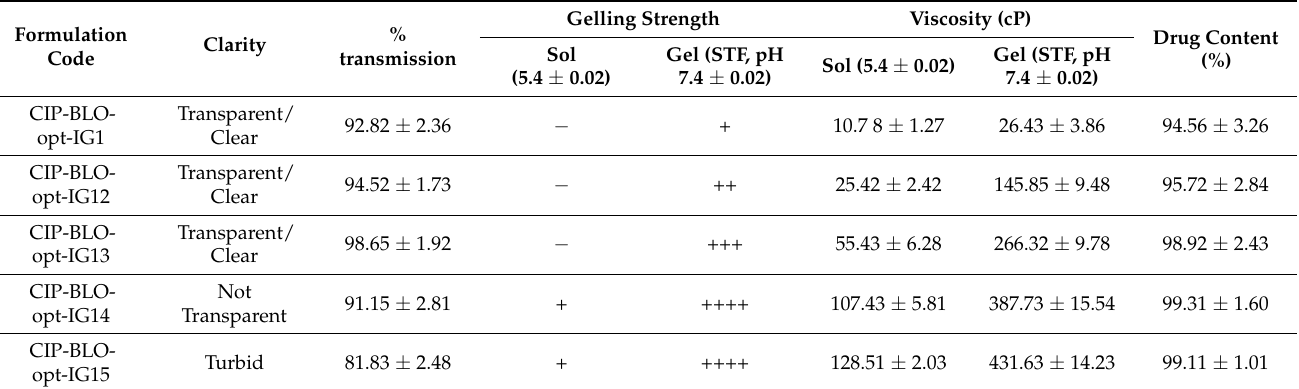
Table 3. Various evaluation parameters of